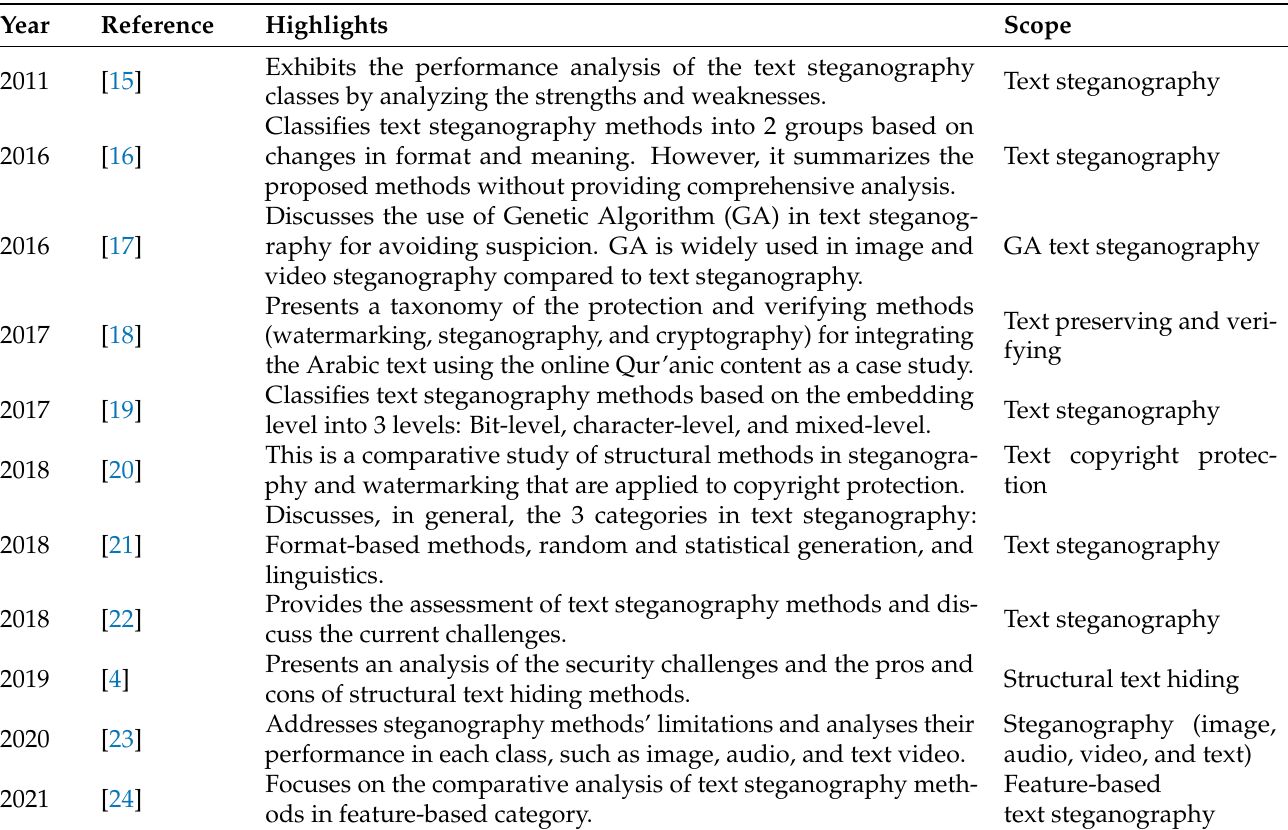
Table 1. Prior surveys on text